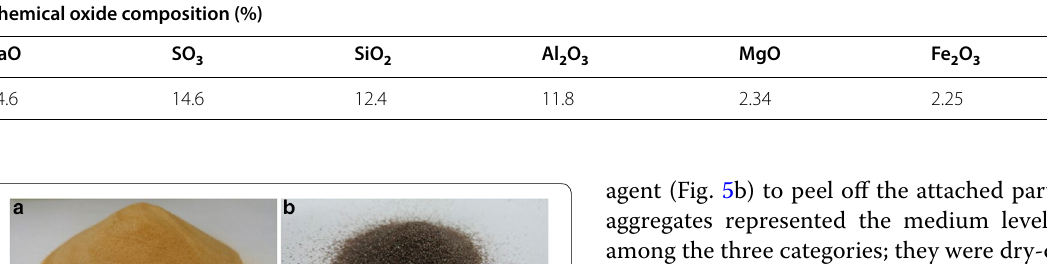
Table 1 Chemical oxide composition of cement.